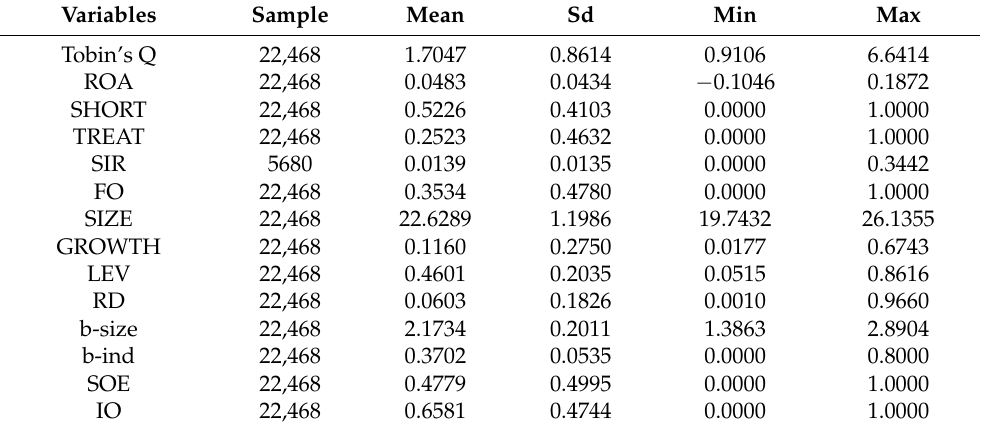
Table 3. Summary